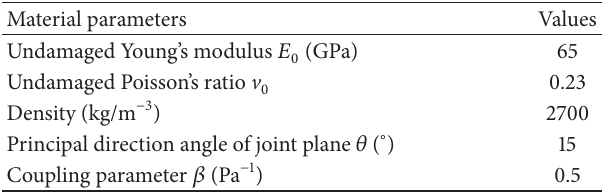
Table 3: Parameters used in the model to validate the model in simulating the anisotropic properties of stress and